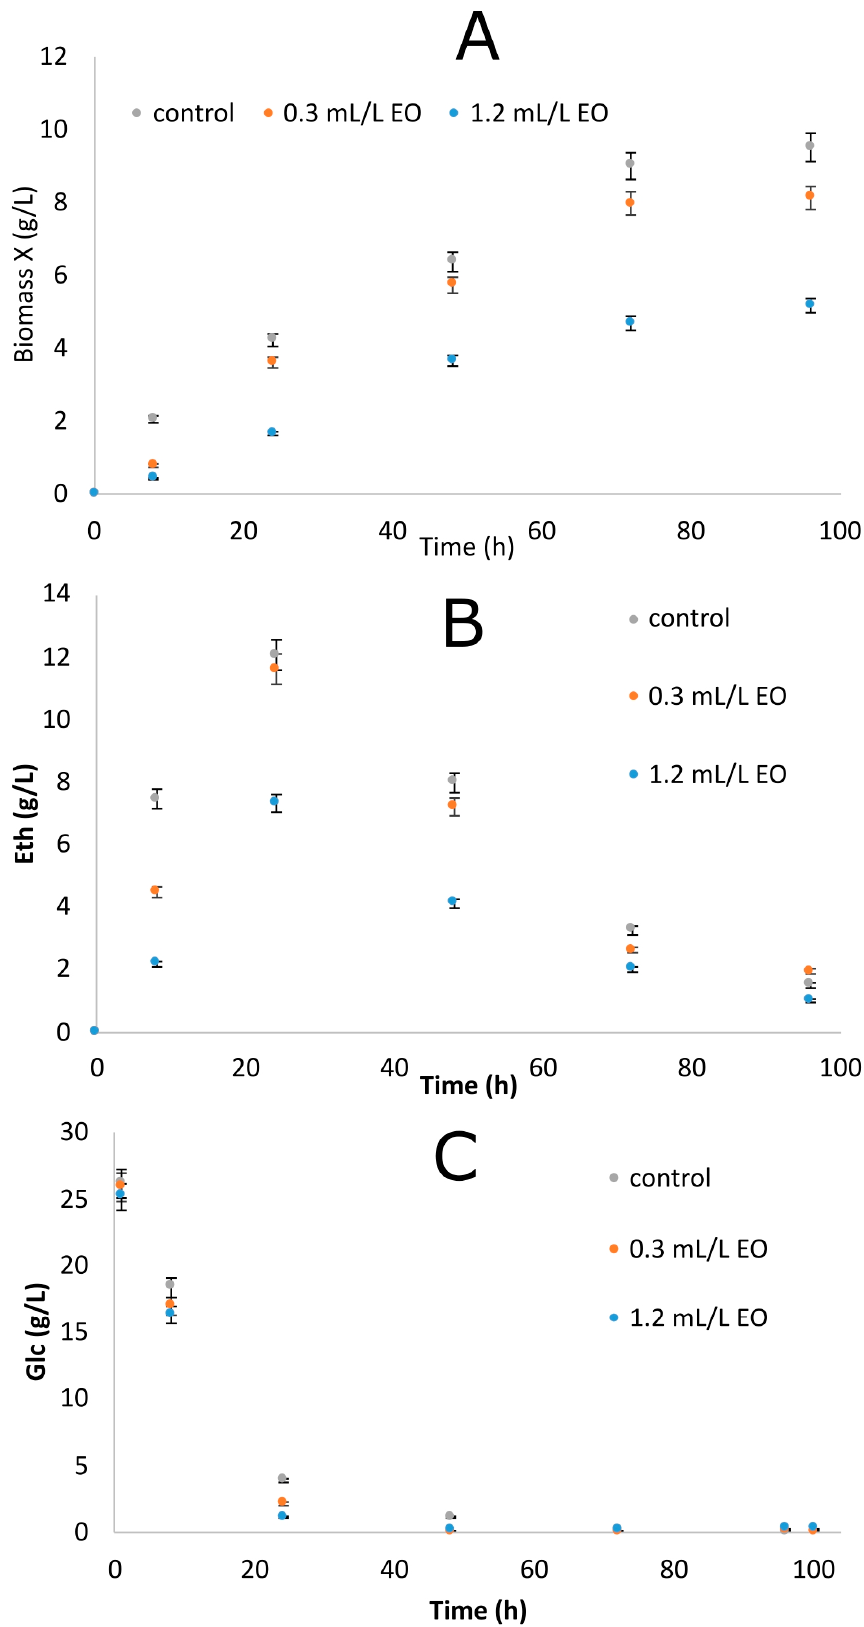
Figure 1. Changes in biomass (X, g/L) ( A ), ethanol (Eth, g/L) ( B ), and glucose (Glc, g/L) ( C ) during growth of Saccharomyces cerevisiae in the absence (control) and presence of EO from the Citrus sinensis cv Citrus aurantium plant.